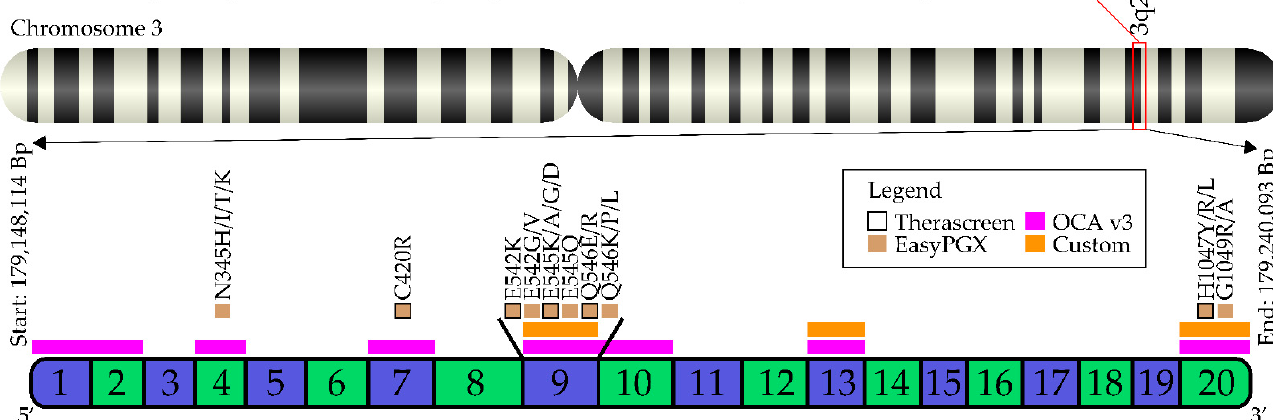
Figure 2. Exon structure of PIK3CA gene with reference range of the assays employed in this